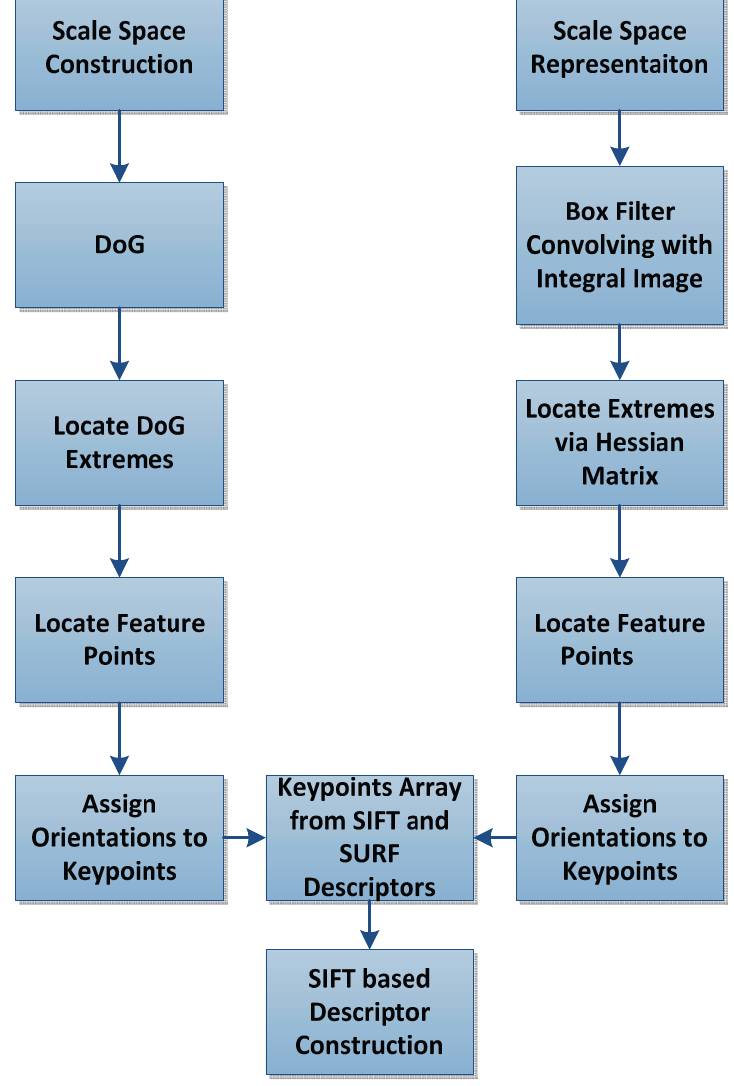
Figure 1. Overview of the Hybrid